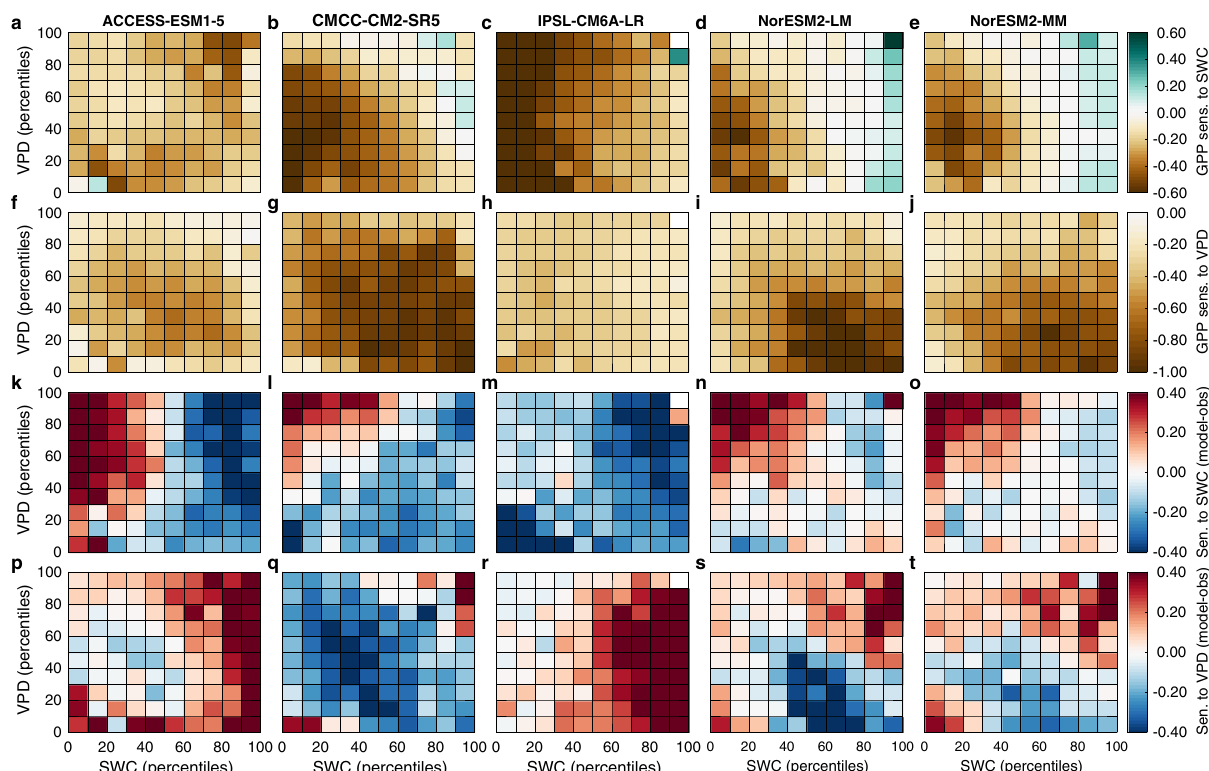
Fig. 4 The sensitivity of gross primary production to soil water content and vapor pressure de fi cit using fi ve Earth System Models. a – j The sensitivity of gross primary production (GPP) to soil water content (SWC) and vapor pressure de fi cit (VPD) using fi ve Earth System Models. k – t The differences (modeled sensitivity minus observation-based sensitivity) for GPP to SWC ( k – o ) and VPD ( p – t